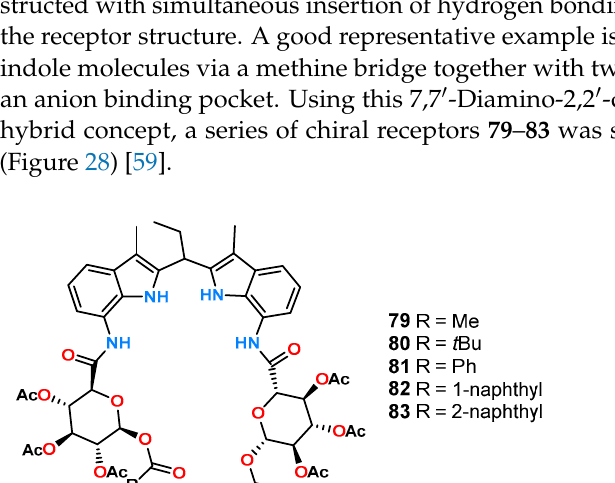
Table 5. Chiral recognition of amino acids as tetrabutylammonium salts by receptors 79–83 in